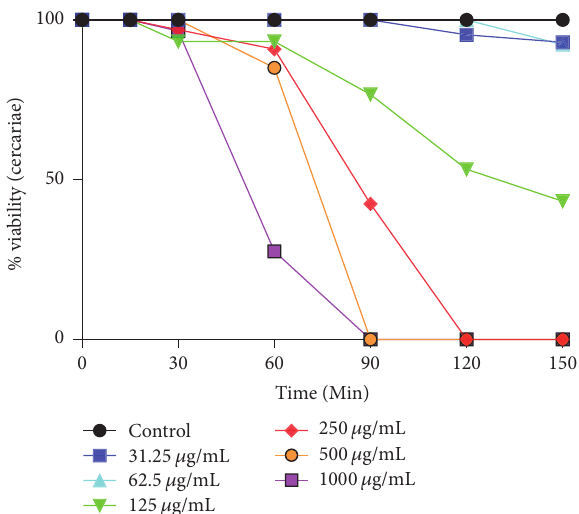
Figure 2: Effect of different concentrations of R. vomitoria roots on the viability of Schistosoma mansoni